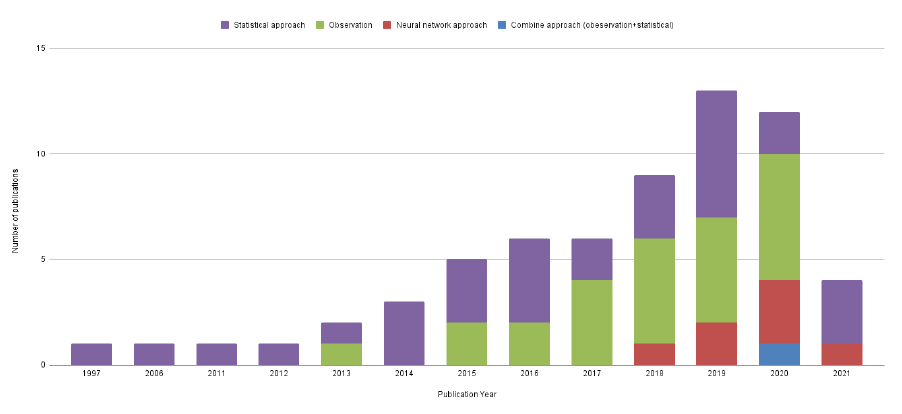
Figure 3. Performance analysis methods of selected publications given the publication year.